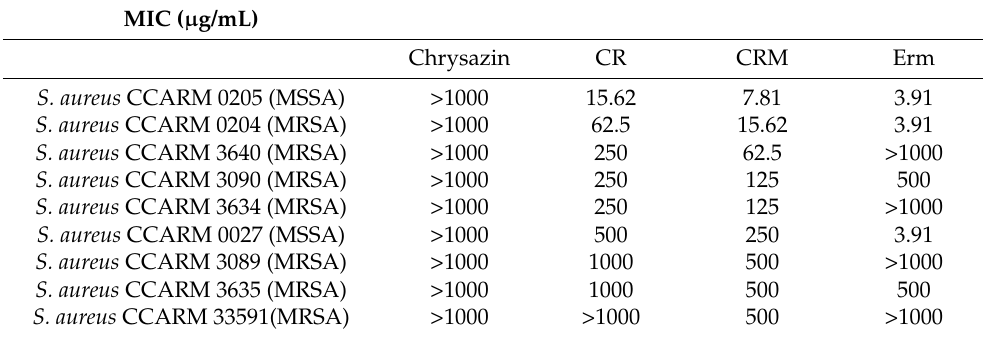
Table 2. MIC values of compound chrysazin, CR, CRM, and erythromycin (Erm) against 9 strains. MIC ( µ g/mL)